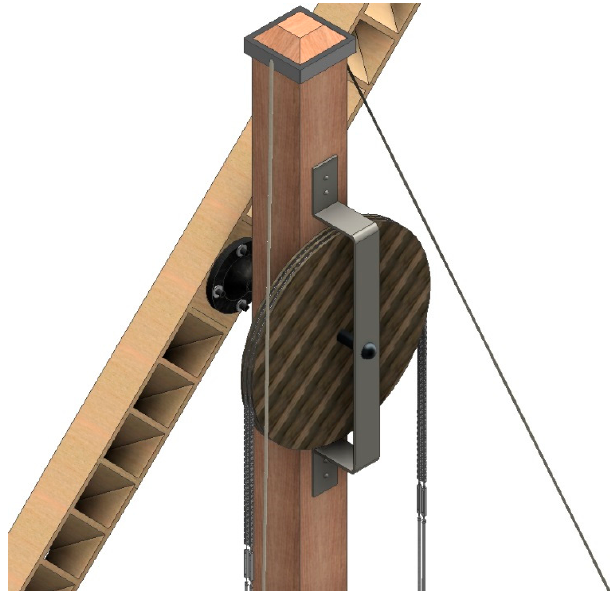
Figure 8. Detail of the upper wheel.